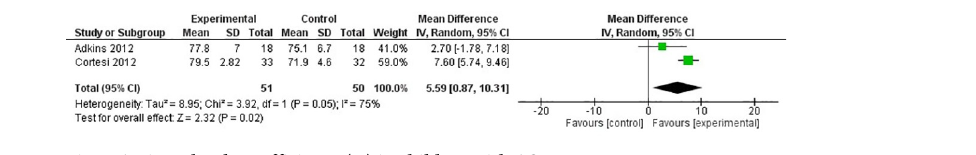
Fig 4. Actigraphy sleep efficiency (%) in children with ASD.